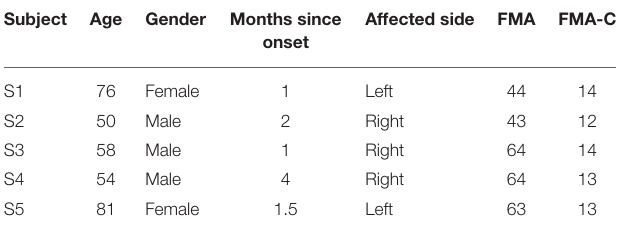
TABLE 1 | Details of five post stroke